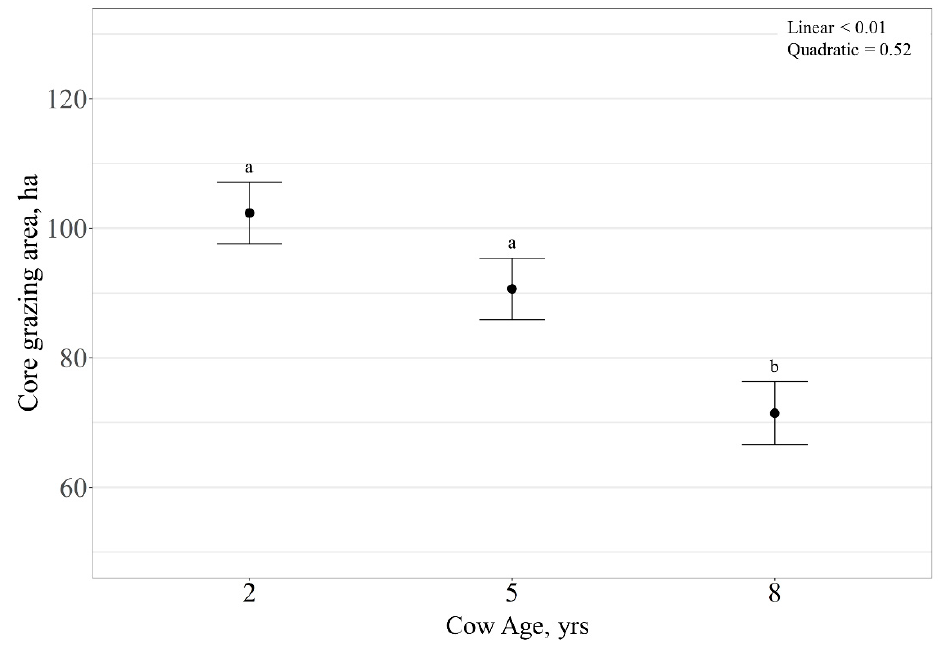
Figure 9. Influence of cow age on core grazing area (expressed as ha ± SE) by cattle grazing dormant northern mixed-grass prairie in 2018/2019 and 2019/2020 at the Northern Agriculture Research Center’s Thackeray Ranch, Havre, MT, USA. Means lacking common letters (a, b) differ ( p < 0.05).